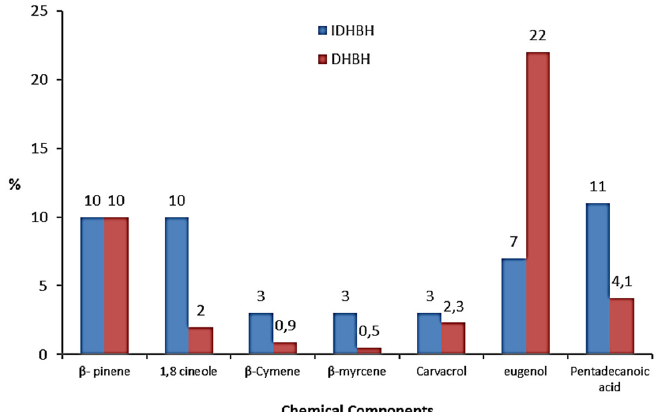
Figure 5. The comparative diagram of the main essential oil constituents of Eucalyptus polybractea (L.) by IDHBH and DHBH methods of this